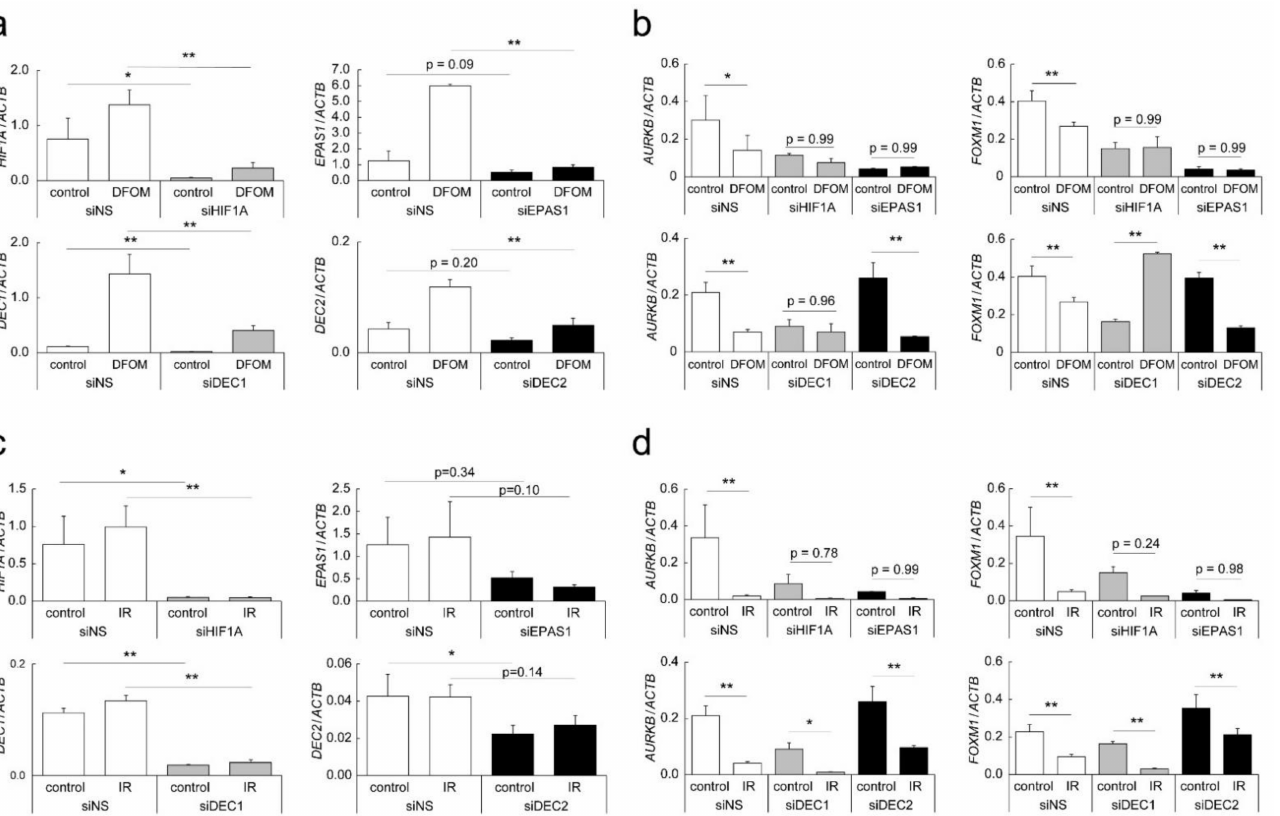
Figure 4. Regulatory mechanisms of AURKB and FOXM1 expression. Knock-down experiments were performed by using transient transfection with specific siRNA for HIF1A , EPAS1 , DEC1 , and DEC2 . ( a , c ) Expression of HIF1A , EPAS1 , DEC1 , and DEC2 in DFOM-treated ( a ) or irradiated (1000 mGy/day) ( c ) TIG-3 cells analyzed by quantitative RT-PCR. ( b , d ) Expression of AURKB and FOXM1 in DFOM-treated ( a ) or irradiated (1000 mGy/day) ( c ) TIG-3 cells analyzed by quantitative RT-PCR. ( a – d ) Relative gene expression levels calculated as the ratio to that of ACTB . Values are means and SD ( n = 3). * p < 0.05; ** p <